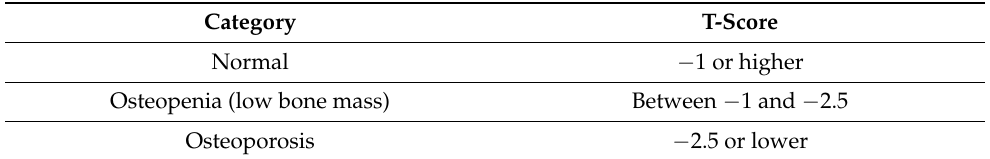
Table 1. World Health Organization (WHO) diagnostic criteria for osteoporosis based on DXA bone mineral density.